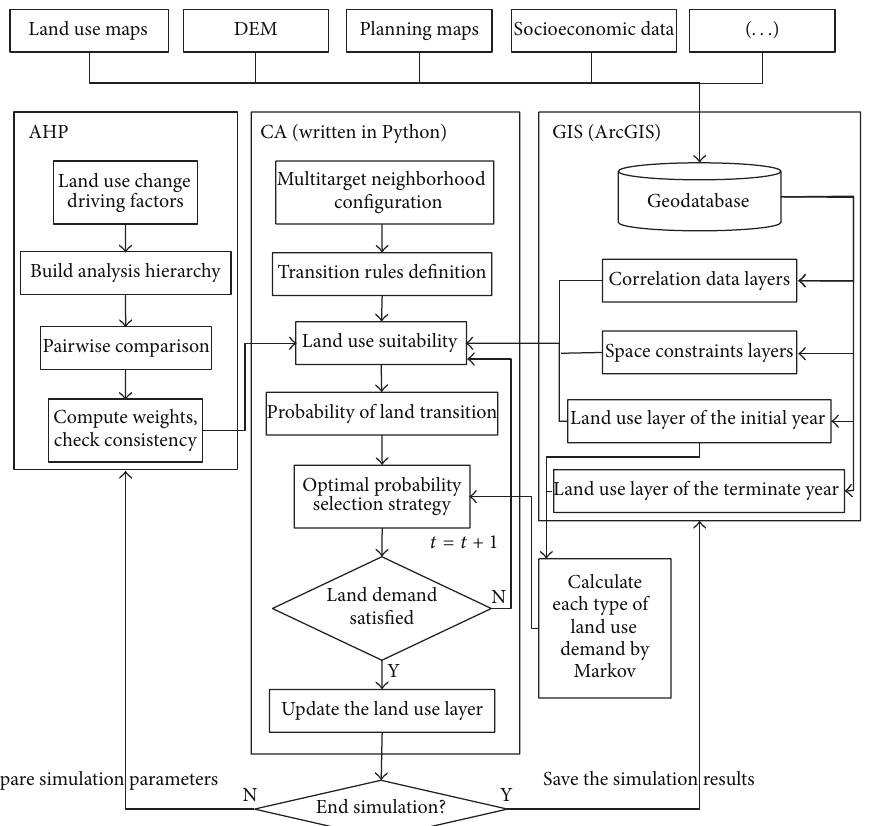
Figure 1: Flowchart of multitarget land use change simulation model based on cellular